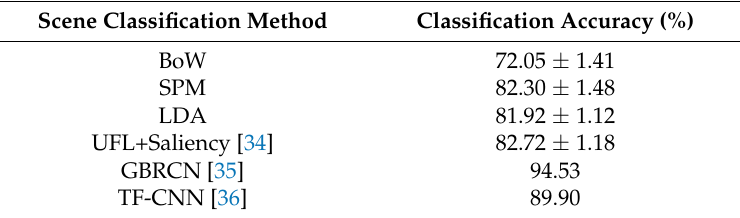
Table 1. Scene classification results for the UC Merced